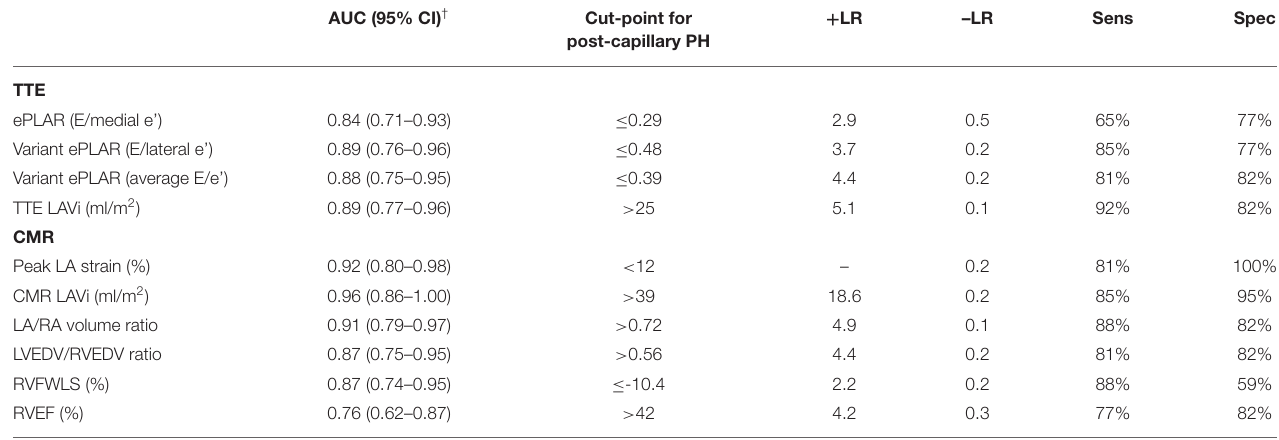
TABLE 5 | Comparison of predictive ability/AUC of 10 discriminator parameters with associated cut-points for post-capillary PH diagnosis.